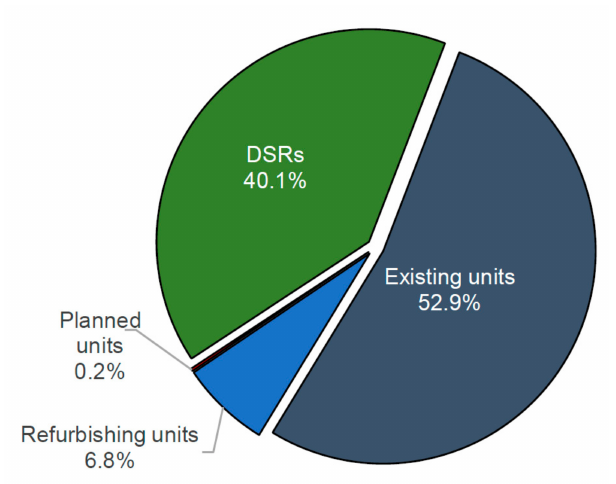
Figure 12. Capacity obligation volume contracted in main capacity auction for 2025 delivery year– break down by official (declared) assignments to capacity market units. Source: Own analysis based on [41].